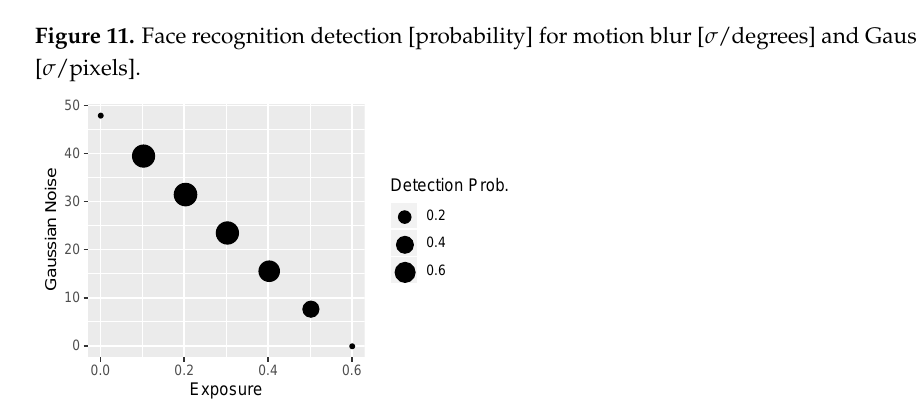
Figure 12. Face recognition detection [probability] for overexposure [eq units] and Gaussian noise [ σ /pixels].